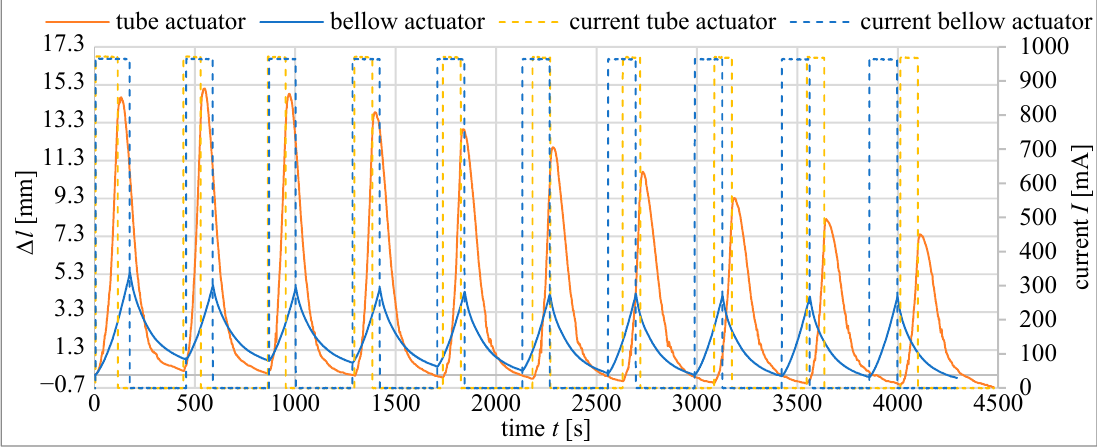
Figure 19. Blocking stress of actuators as a function of relative elongation for a temperature of 75 °C.